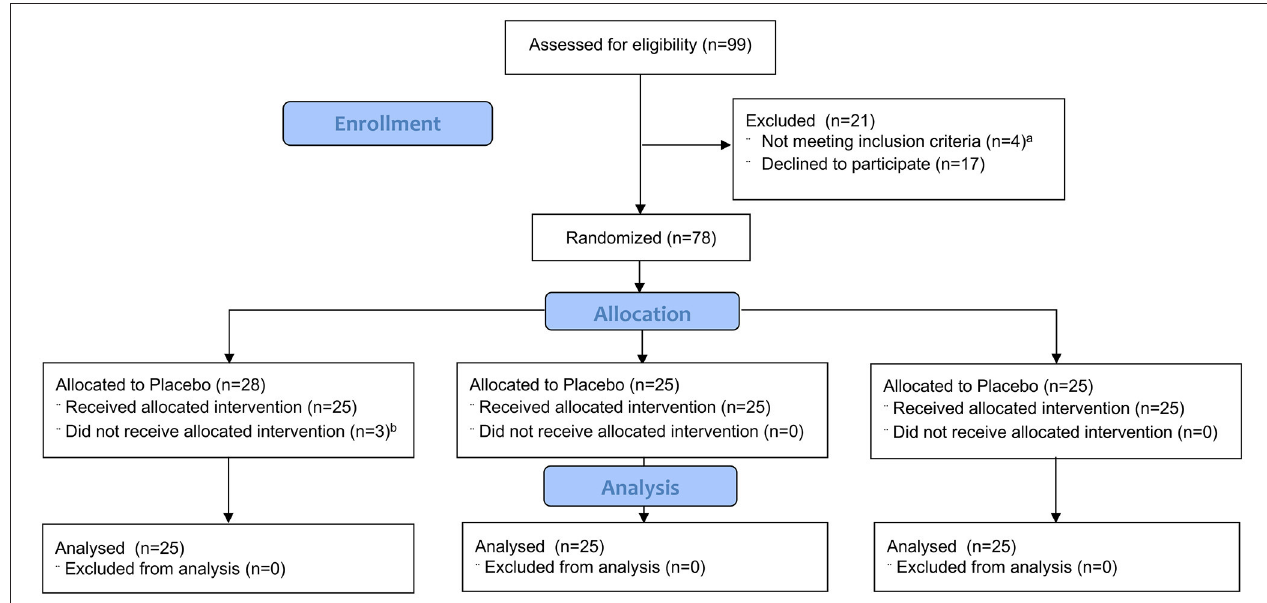
FIGURE 1 | CONSORT flow diagram. CONSORT, Consolidated standards of reporting trials. a Reasons for exclusion: 4 patients received sedative premedication. b Reasons for not receiving allocated intervention: 3 patients developed mild laryngospasm at induction that required intravenous anesthetics.